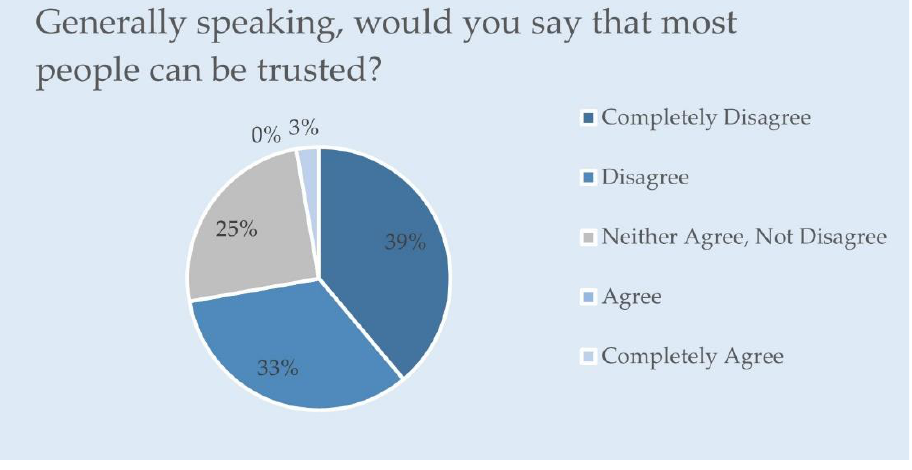
Figure 17. Distribution of responses from a survey.